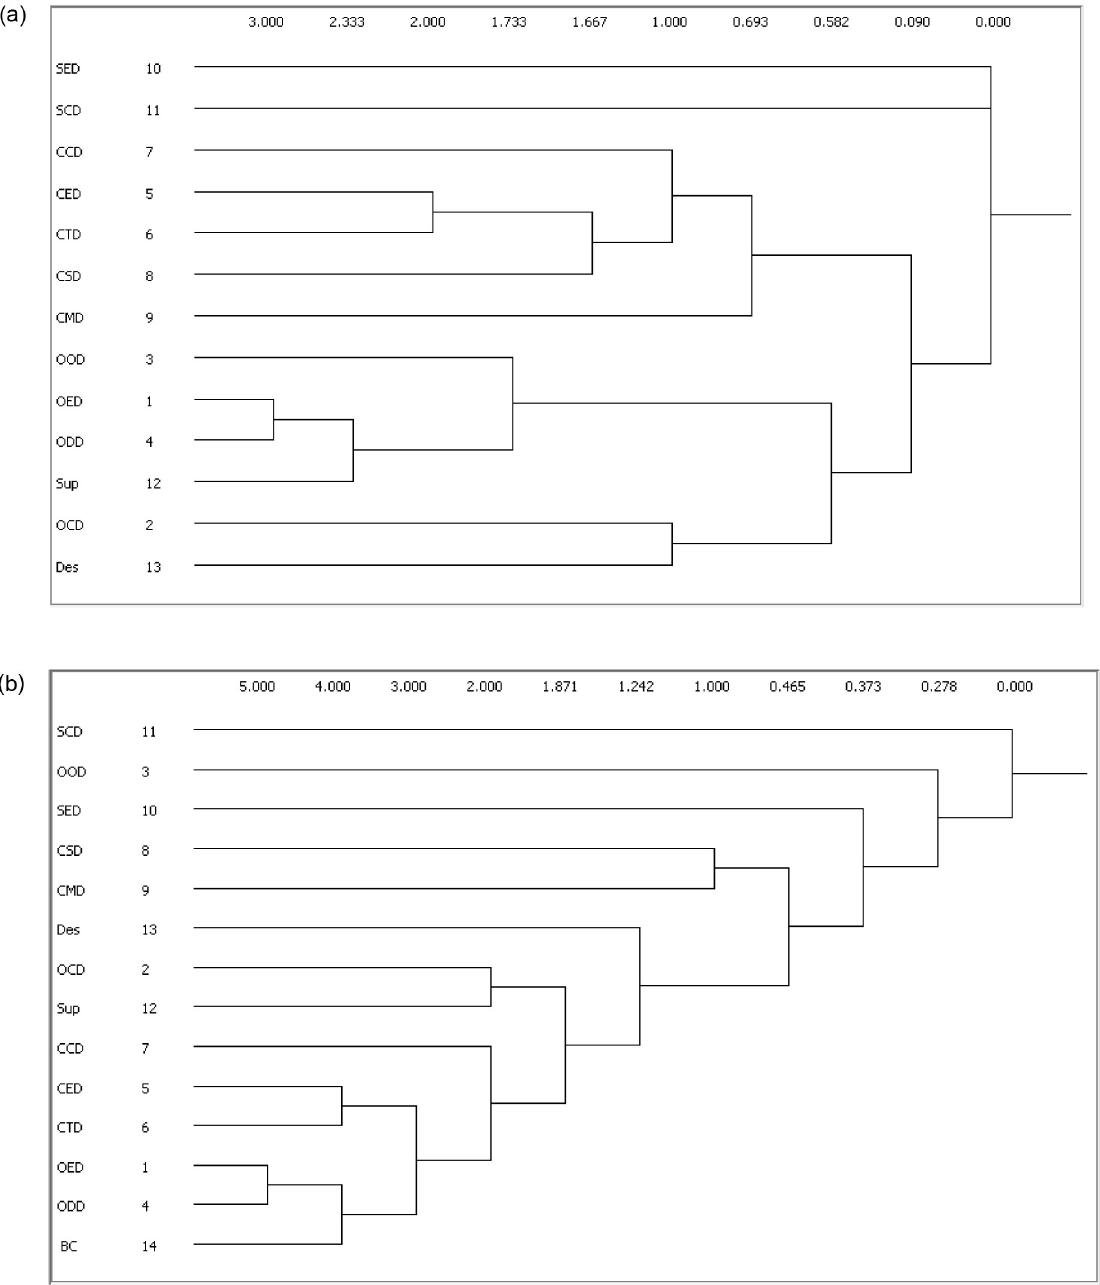
Fig 7. Dendrograms of cliques’ analysis. (a) Before BIM use. (b) After BIM use.